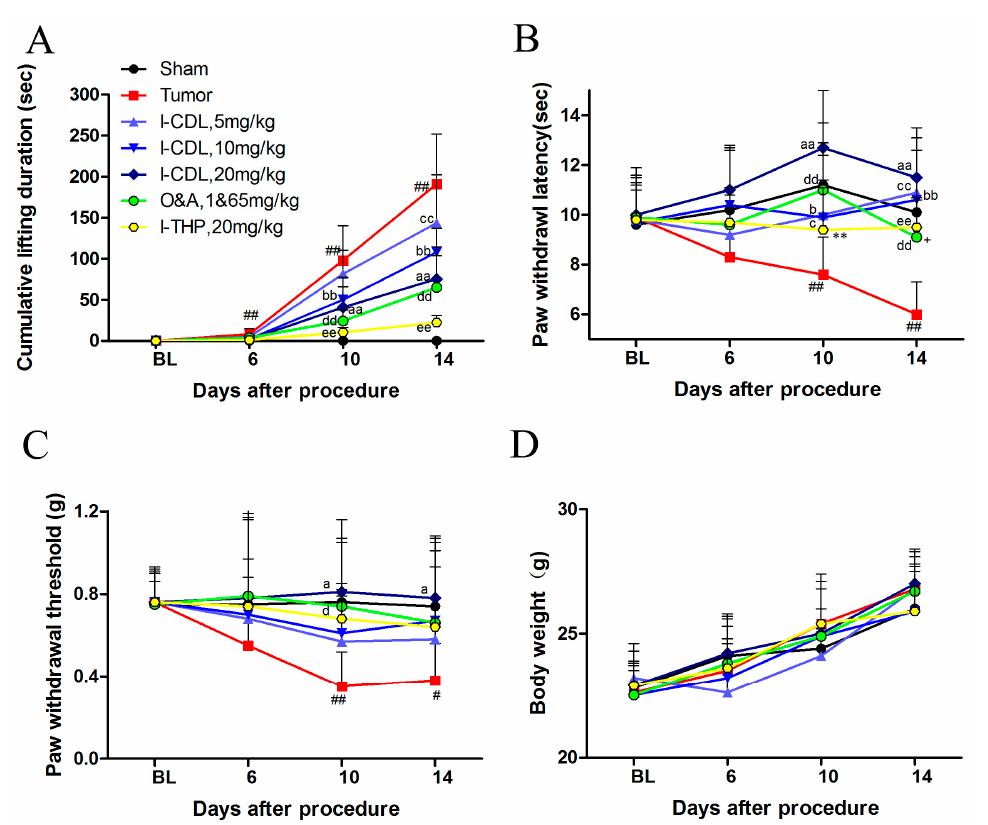
Figure 2. l -CDL attenuates tumor compression-induced cancer pain hypersensitivity. ( A ) Time course of cumulative lifting duration in mice; ( B ) l -CDL attenuated paw withdrawal latency of the hind